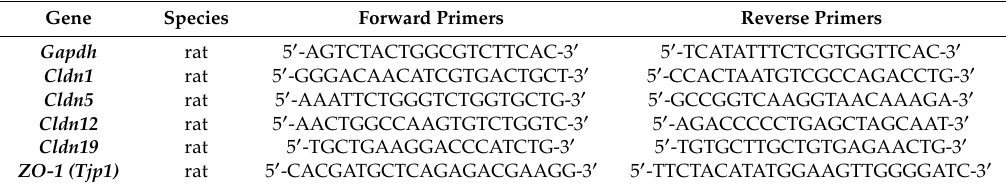
Table 2. List of primers used in qRT-PCR